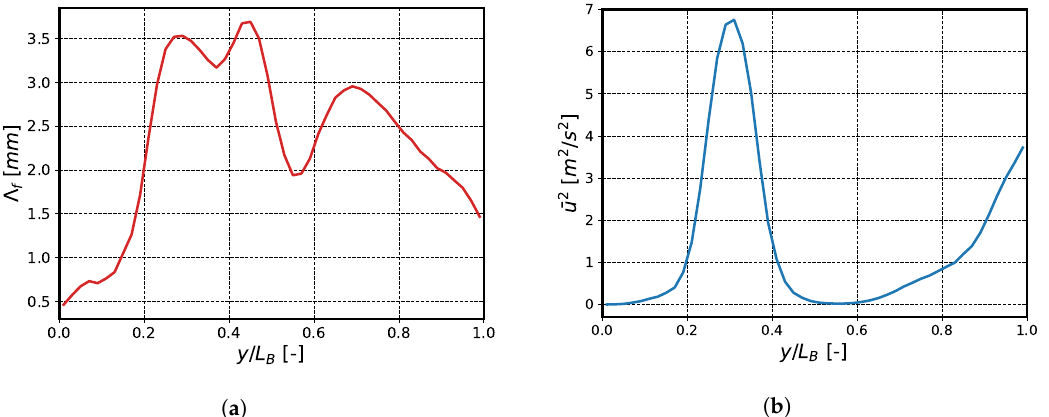
Figure 4. Inlet turbulence parameters are extracted from the steady-RANS computation in upstream of the blade leading-edge line and depicted as functions of the spanwise normalized distance y / L B : in ( a ), the mean square of the velocity fluctuations u 2 is depicted; in ( b ), the characteristic length scale of the turbulent eddies Λ f is illustrated.